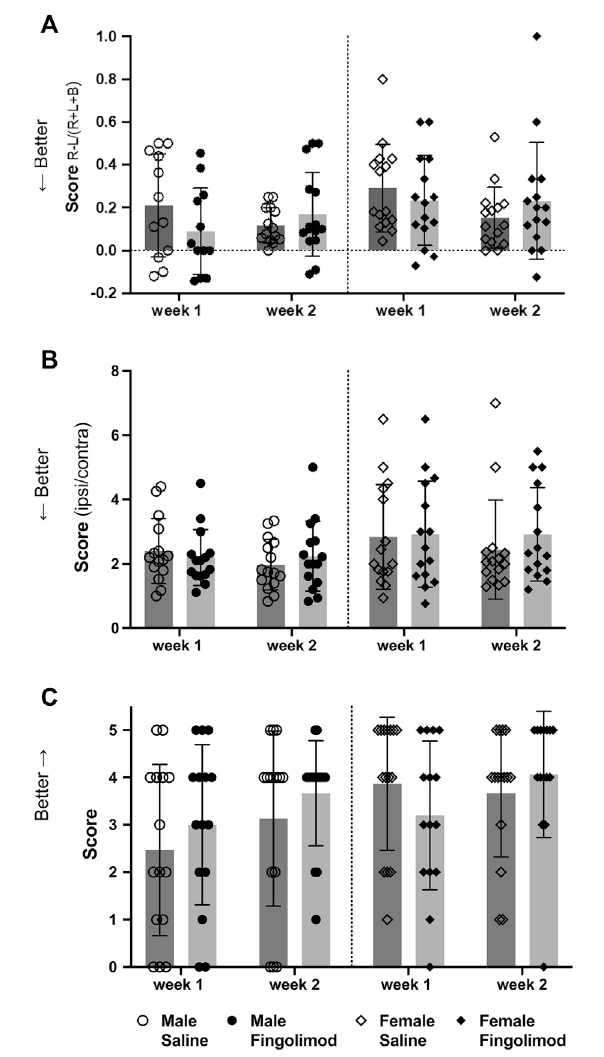
FIGURE4| Behavioural testscoresat twotimepoints afterintracerebral haemorrhage: ( ○ ) saline-treated males, ( C ) fi ngolimod-treated males, ( ◇ ) saline-treated females ( ◆ ) fi ngolimod-treated females). Mice were assessed using the cylinder test (A) : 6 and 13 days after collagenase injection. They were assessed using the foot fault test (B) : 7 and 14 days after collagenase injection. Finally, their performance in the wire hanging test (C) : wasassessedonthesamedaysasthefootfaulttest.Scoresin (A) and (B) are shown as means ± SD, while wire hanging scores (C) are shown as medians ± 95% con fi dence intervals. There was no difference between the scores of saline- and fi ngolimod-treated mice.